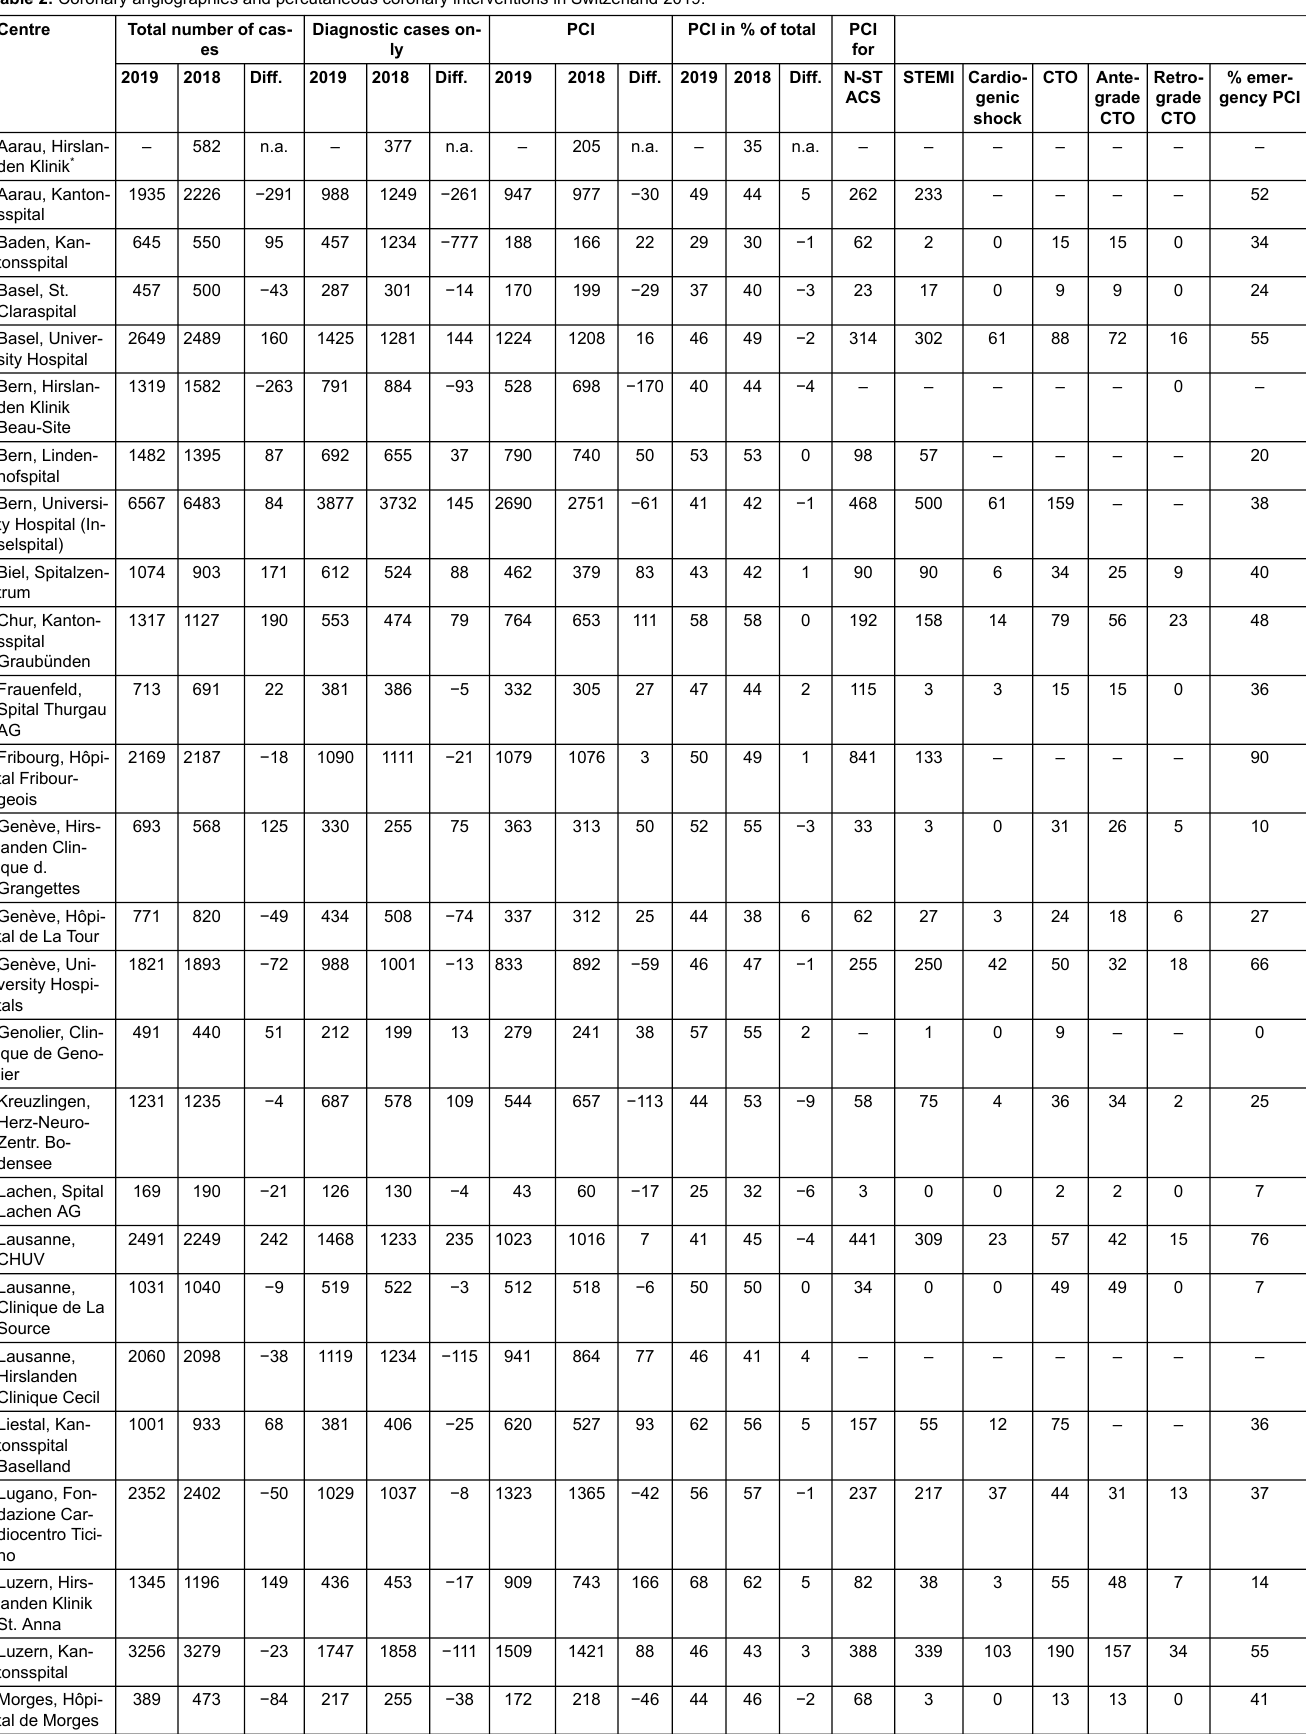
Table 2: Coronary angiographies and percutaneous coronary interventions in Switzerland 2019. Centre Total number of cas-